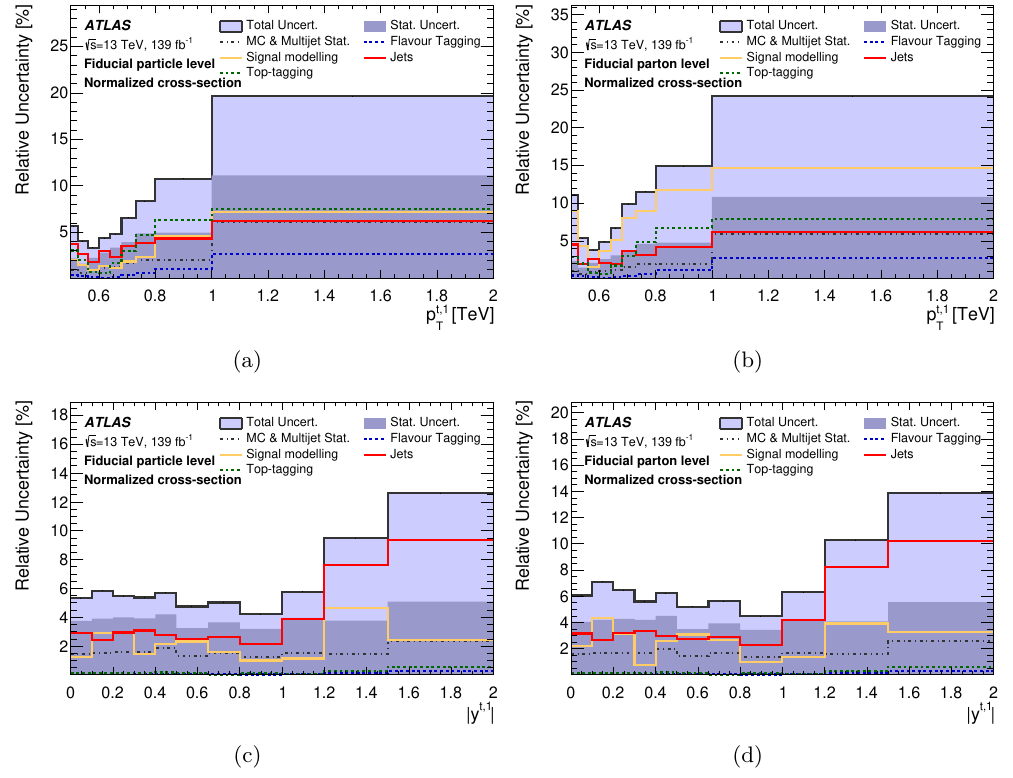
Figure 8 . Relative uncertainties in the normalized differential cross-sections as a function of the leading top-quark-jet p T and rapidity at particle level ((a) and (c)) and parton level ((b) and (d)). The light and dark blue areas represent the total and statistical uncertainty, respectively. The ’Jet’ category includes JES, JER, JMS, and JMR systematic uncertainties. The ’Signal modelling’ category includes alternative hard-scattering model, alternative parton-shower model, ISR/FSR, and PDF systematic uncertainties. The Powheg + Pythia 8 generator is used as the nominal prediction to correct for detector